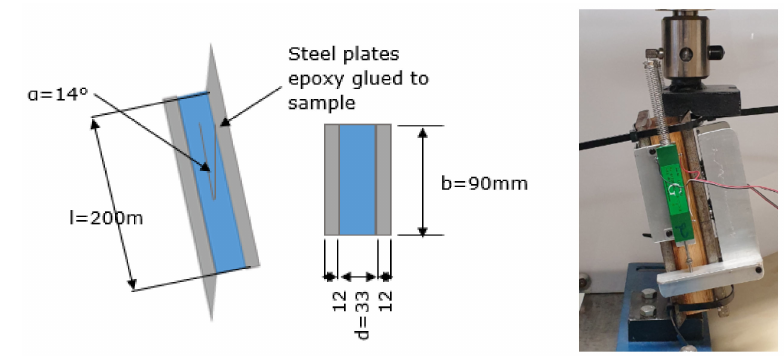
Figure 6. Shear test